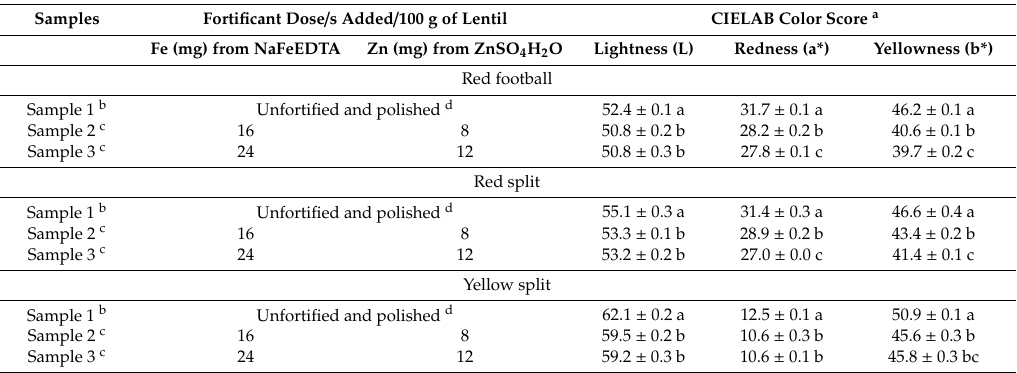
Table 3. Lightness (L*), redness (a*) and yellowness (b*) scores of one unfortified and two dual-fortified dehulled red football, red split and yellow split lentil samples prepared using Fe and Zn from NaFeEDTA and ZnSO 4 H 2 O, respectively.